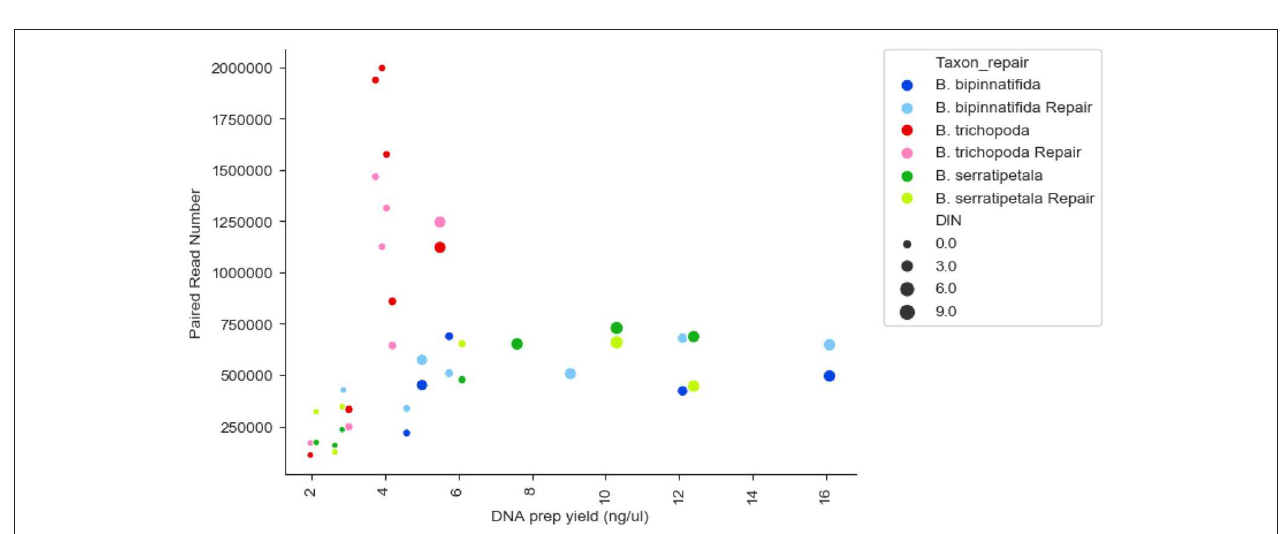
FIGURE 3 | Reads generated per sample by DNA prep yield (ng/ µ l), DNA quality (DIN), and species. Each species has 14 datapoints: one FFPE repaired and one un-repaired for each of the 7 treatments. DIN is represented by size of marker, species by color of marker, repair by shade of marker.